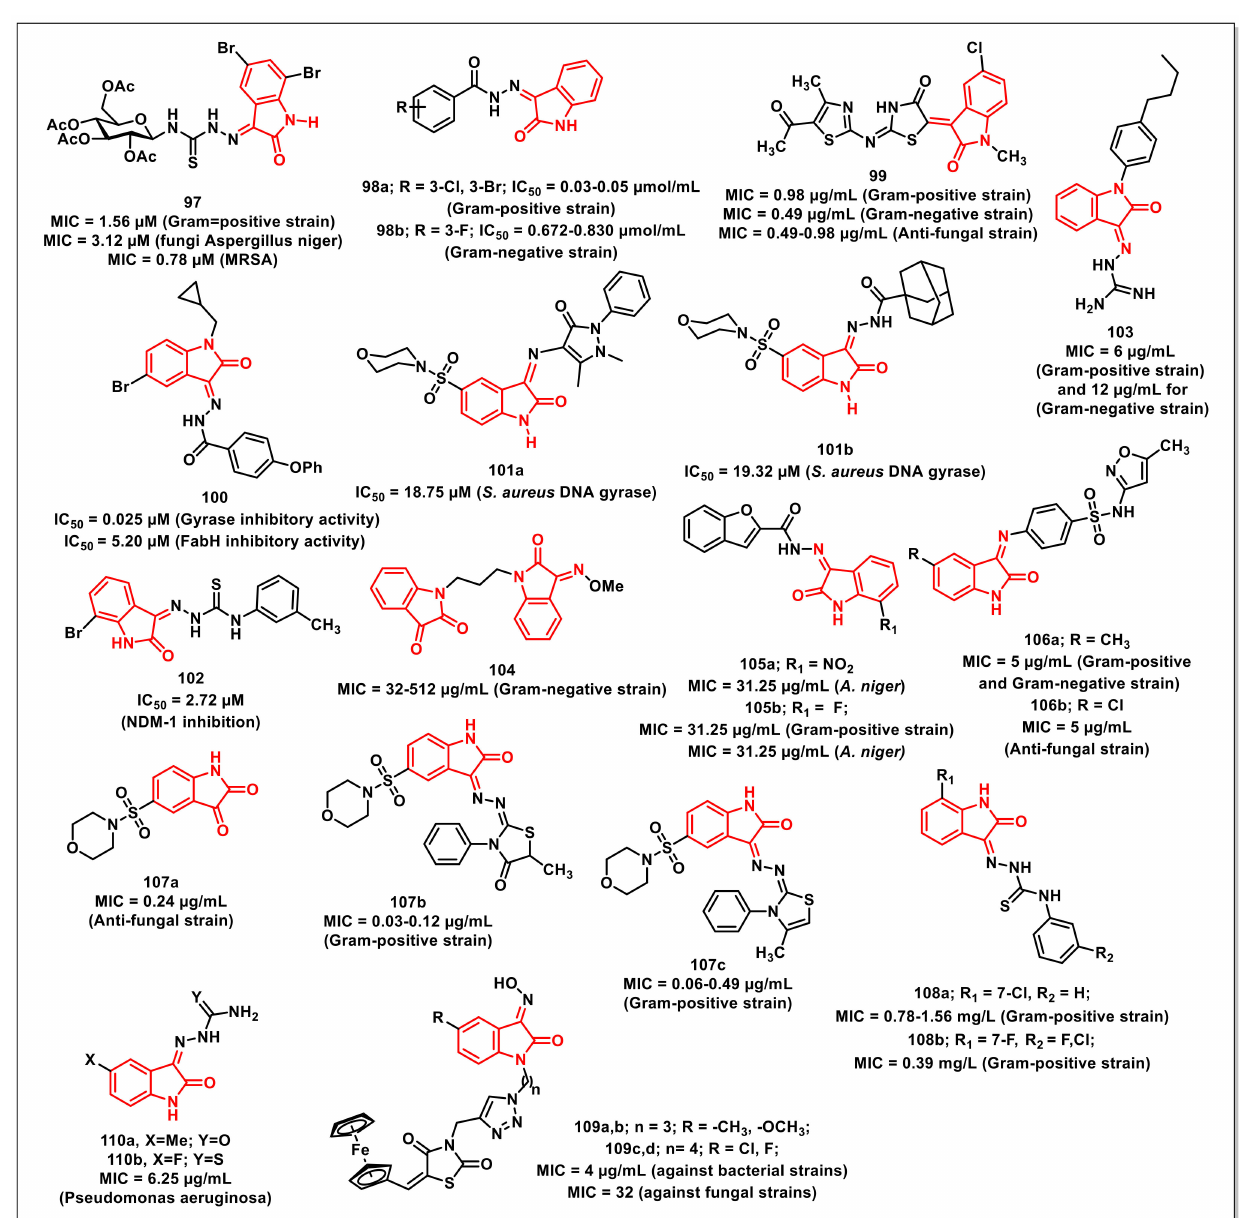
Figure 17. Schiff’s bases and oximes of isatins with antimicrobial